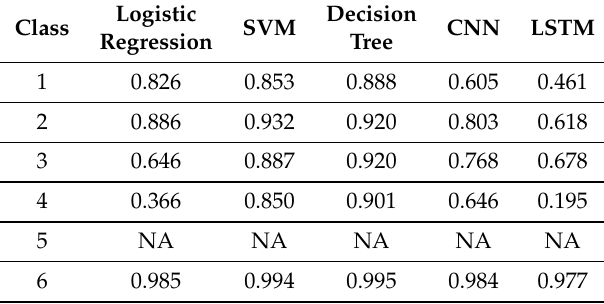
Table 12. Classifier F1-score results.